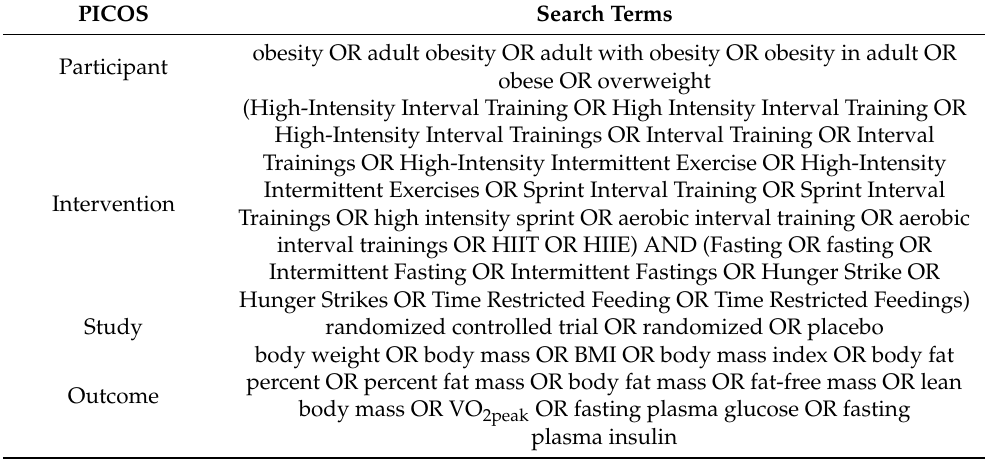
Table 2. Full-search